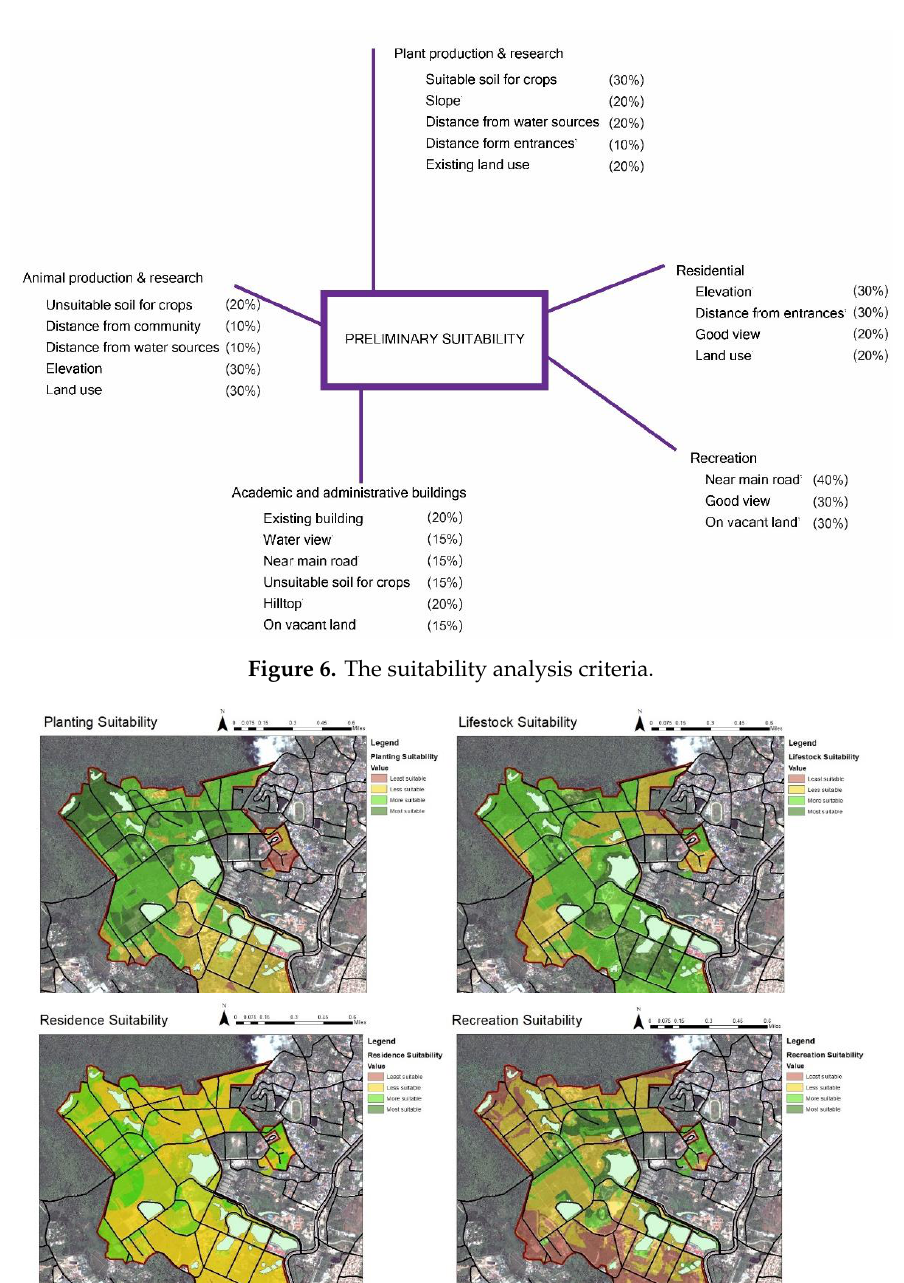
Figure 7. Suitability analysis for each land use needed.